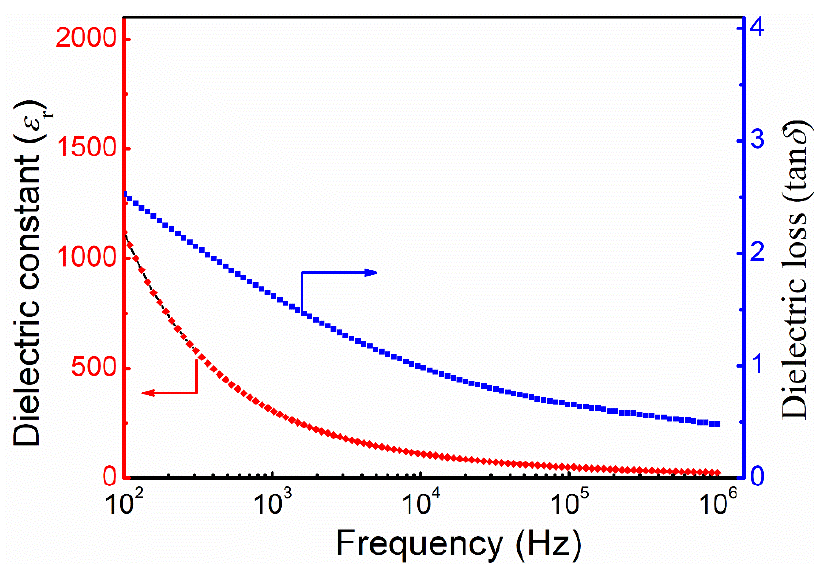
Figure 4. Dielectric constant ( ε r ) and dielectric loss (tan δ ) of the LFRO ceramic sample measured at room temperature as a function of frequency.